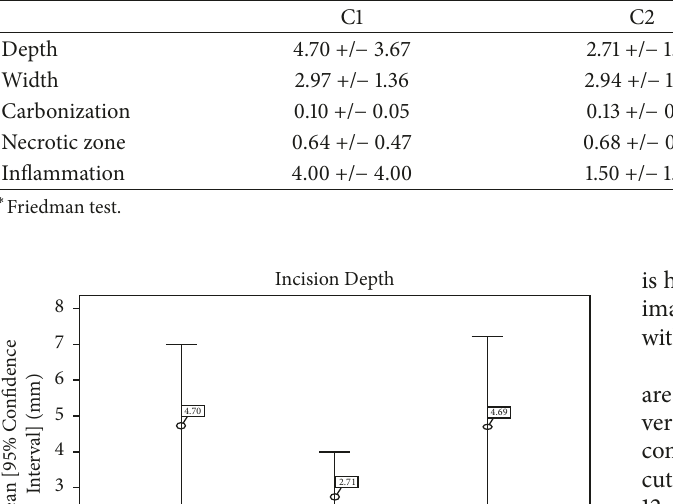
Table 2: Comparison of the three groups for the depth, width, carbonization, and necrotic zone.